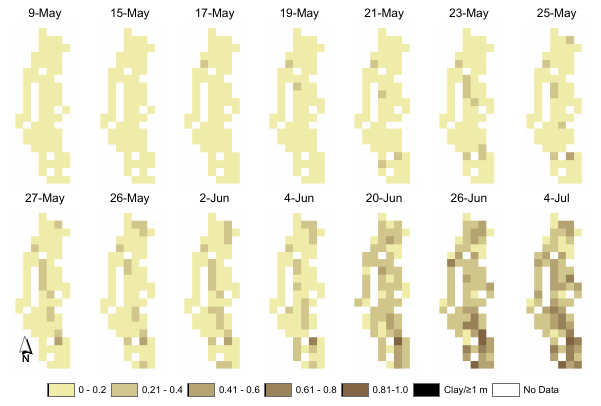
Fig. 7. Frost table depth at the valley site. All values are in m and survey grids are mapped at a resolution of 2m by 2m.